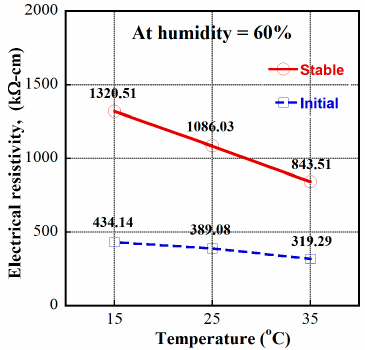
Figure 13. Dependence of electrical resistivity on environmental condition of UHPFRC. Table 6. Electrical resistivity of studied MSFRCs regarding temperature and humidity.